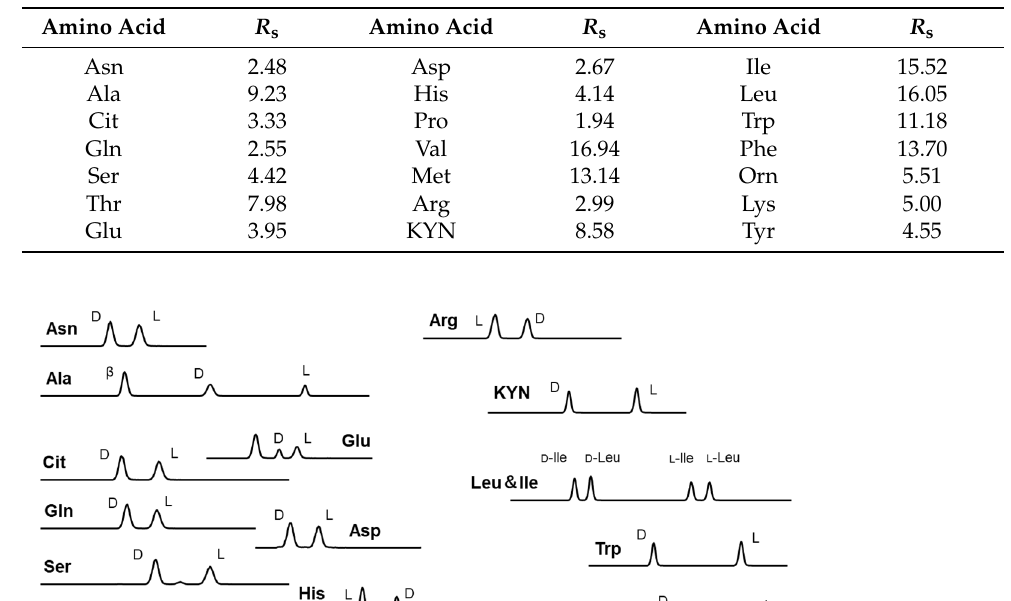
Table 1. Resolutions ( R s ) of the amino acid enantiomers derivatized using CIMa-OSu and the mixed-